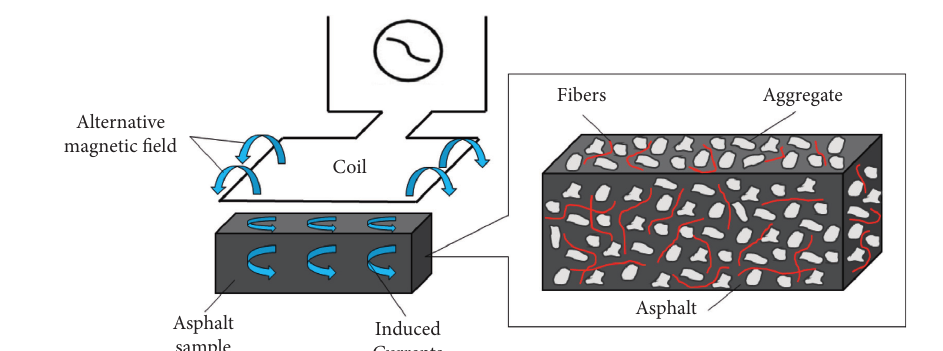
Figure 3: Schematic demonstration of induction healing mechanism for thermoplastic asphalt materials